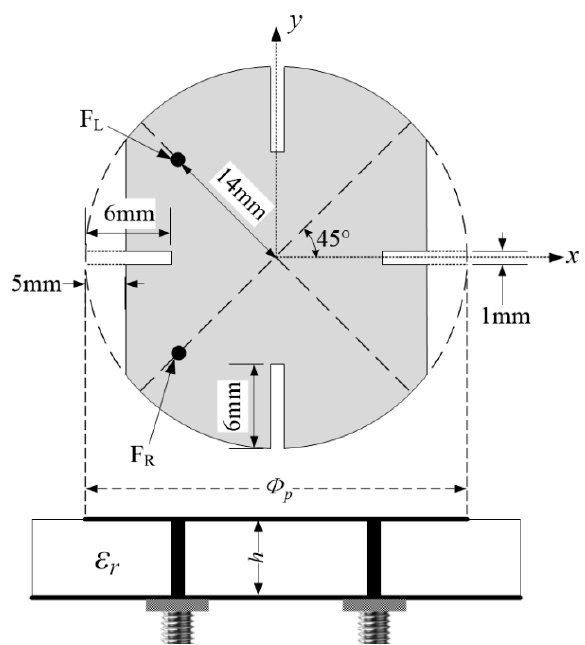
Figure 3. Geometry of the NDCPPA model’s